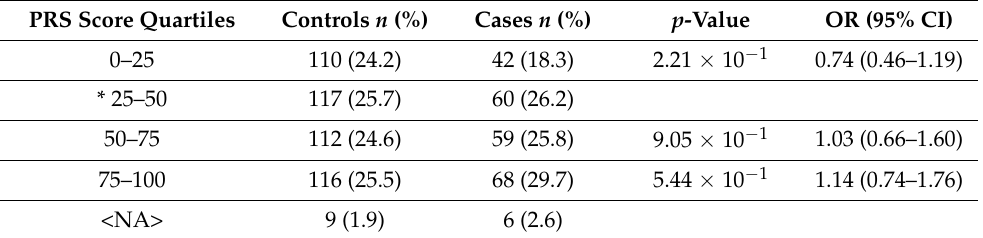
Table 4. ORs, 95% CI and distribution of cases and controls in PRS quartiles before imputation.